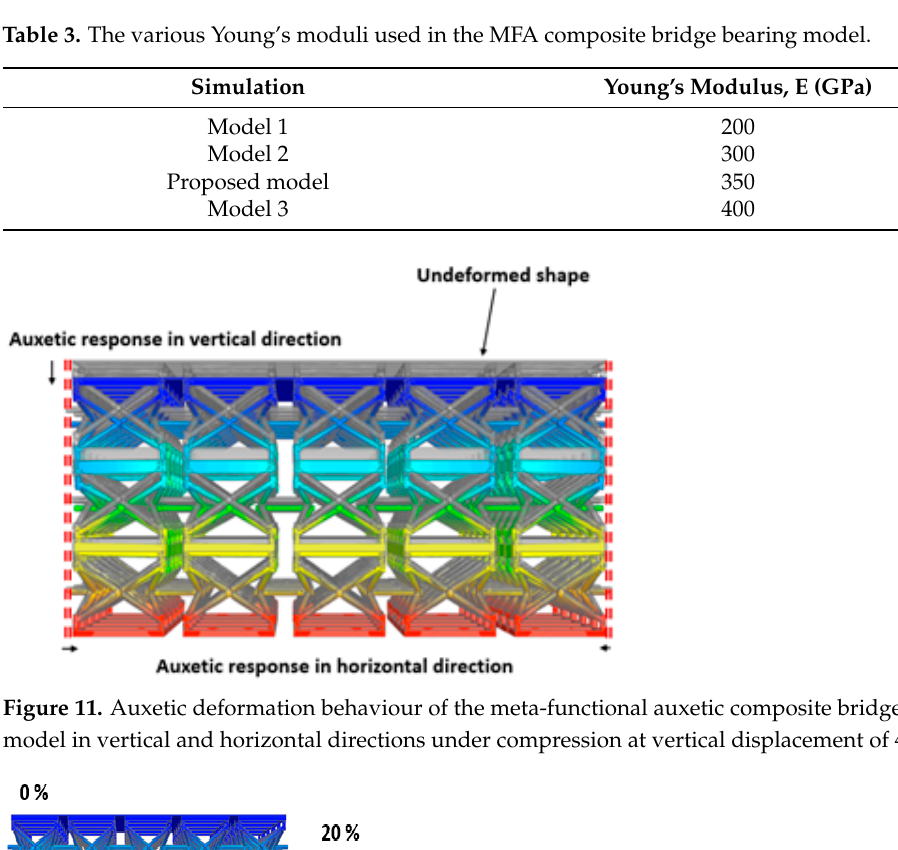
Figure 13. A comparison of the vertical stiffness of the meta-functional auxetic composite bridge bearing model, with different Young’s moduli and a common bridge bearing at the vertical dis- placement of 4 mm, between numerical and experimental relationships, respectively.